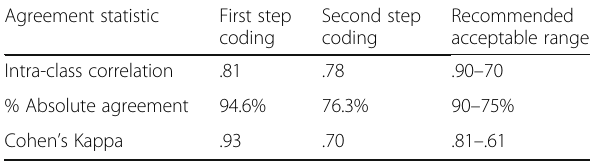
Table 6 Inter-rater agreement indexes between two coders Agreement